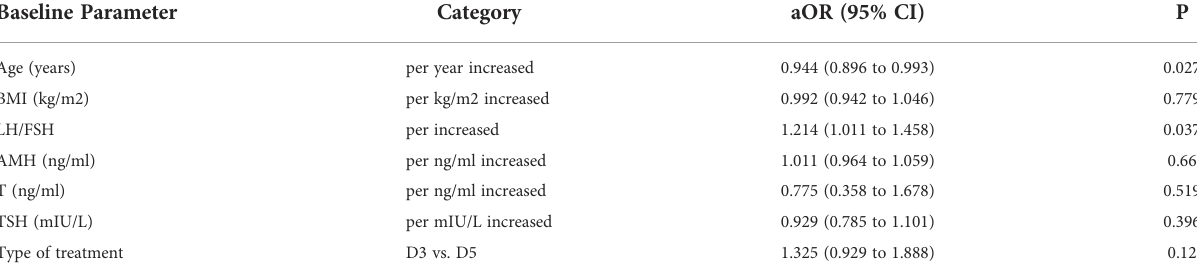
TABLE 2 Logistic Regression of Live Birth Outcome. Baseline Parameter